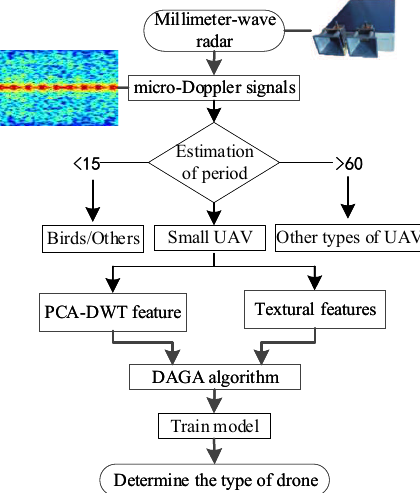
Figure 12. Recognition framework based on dynamic feature attributes.